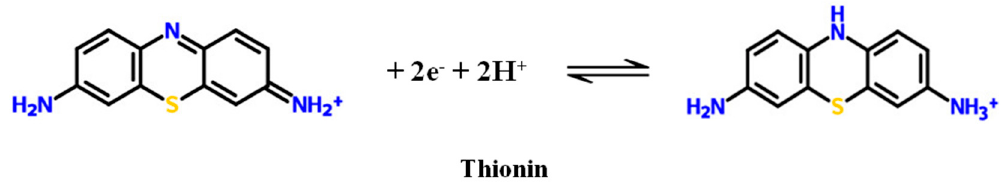
Figure 1. The structure and reversible reaction of thionin.